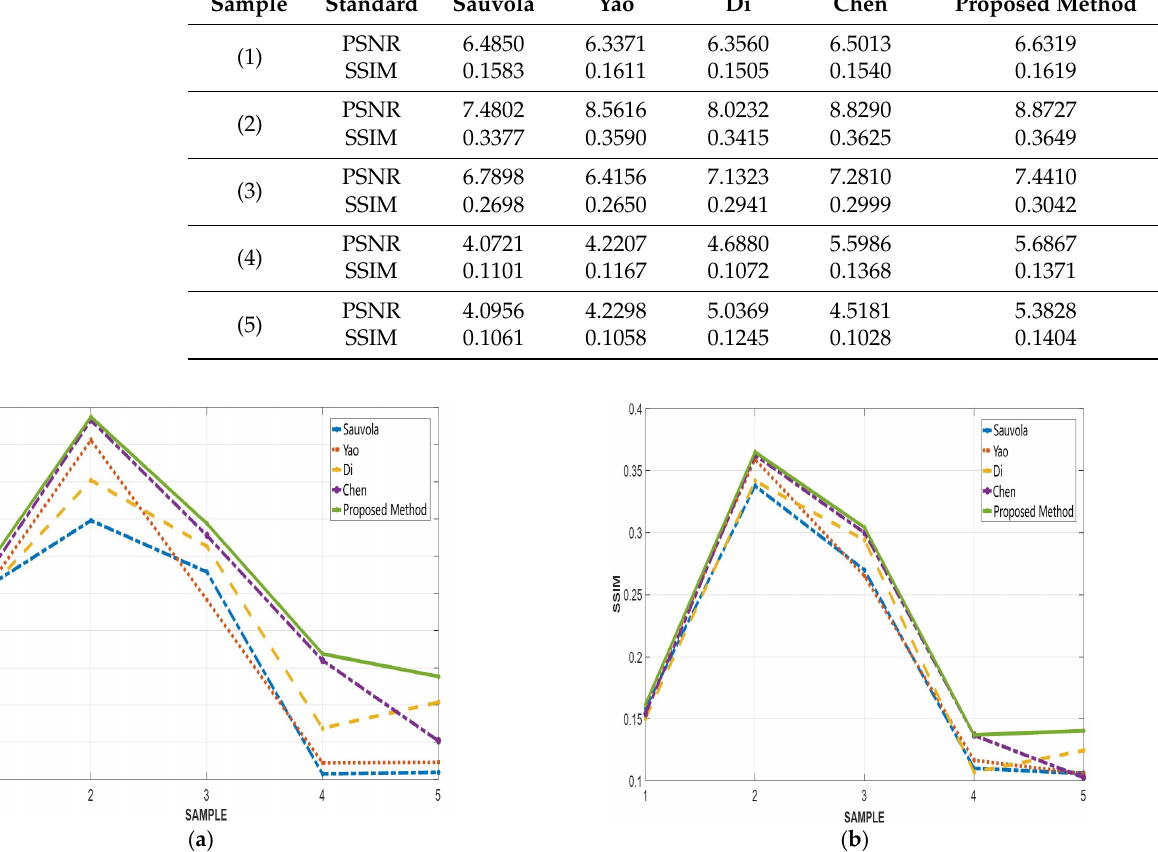
Figure 19. Curves of PSNR and SSIM values of different QR codes after using different algorithms: ( a ) PSNR; ( b ) SSIM.